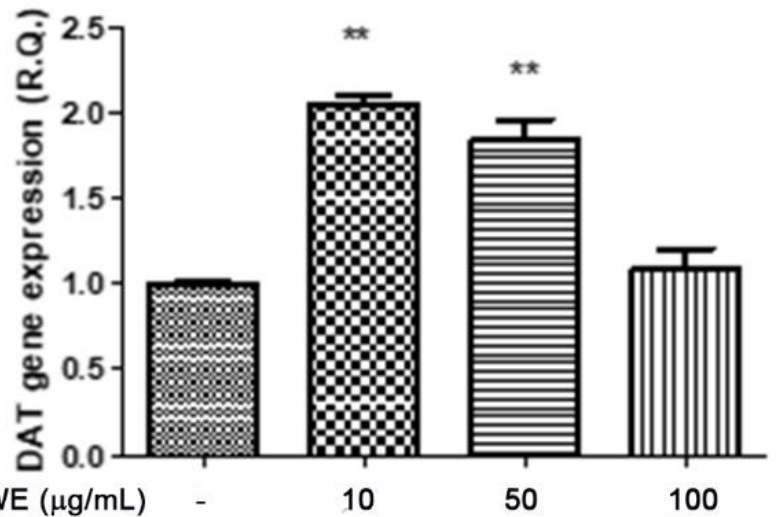
Figure 10. The inhibitory effect induced by Tanacetum parthenium (TPWE: 10–100 µ g/mL) on dopamine transporter (DAT) gene expression in hypothalamic HypoE22 cells. ANOVA, p < 0.001; ** p < 0.01 vs. the untreated control (CTR) group.